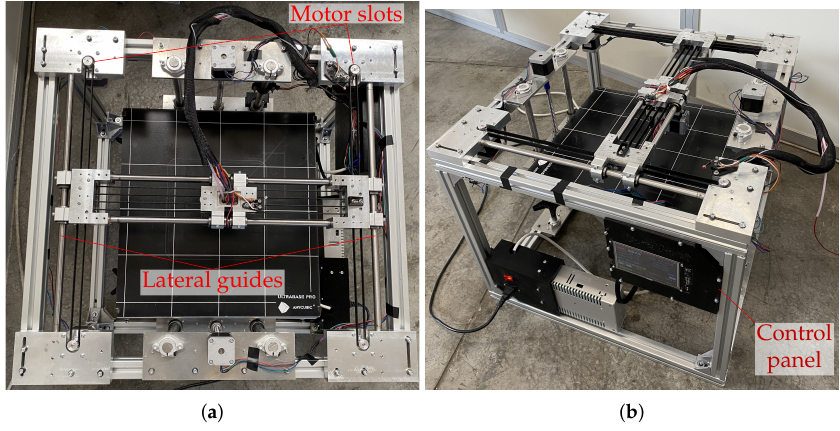
Figure 12. ( a ): Top view of our assembled prototype. ( b ): The same from a side Figure 12. (a) : top view of our assembled prototype. (b) : same, from a side view.